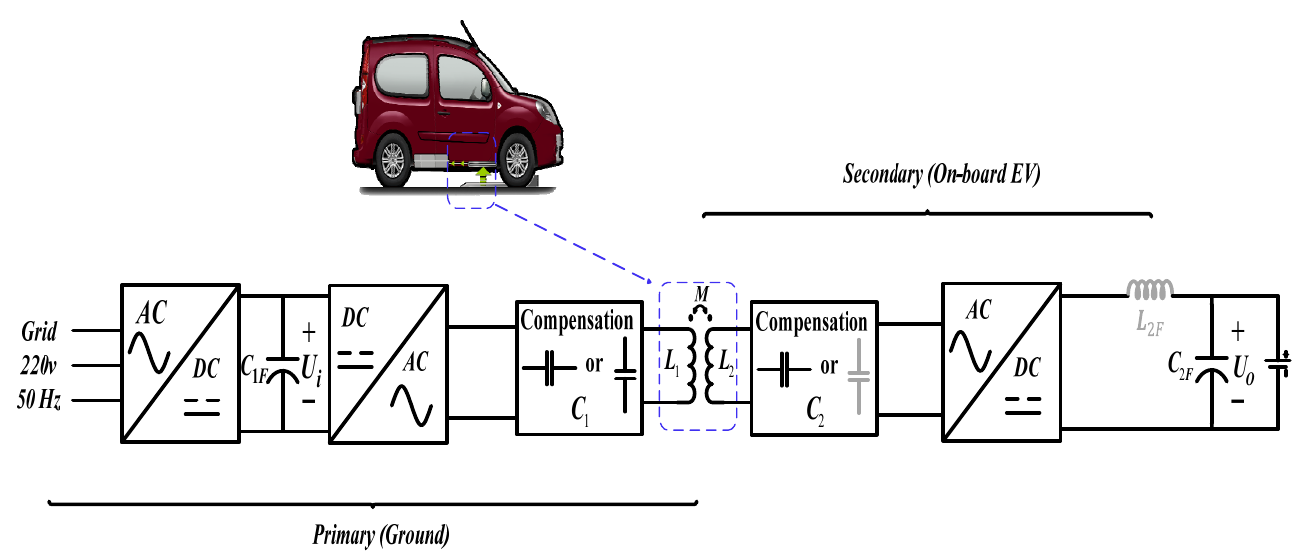
Figure 1. Schematic diagram of IPT (inductive power transfer) charging system for EV (electric vehicle), [52].